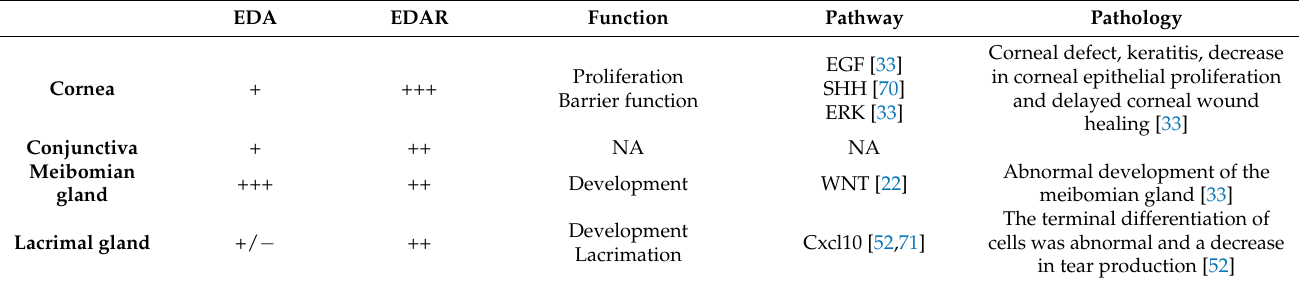
Figure 3. Schematic representation of EDA in ocular surface homeostasis. In ocular surface, the EDA was mainly contributed by meibomian gland. EDA plays a crucial role in maintaining the ocular surface hemostasis by promoting proliferation though EGF signaling pathway and maintaining normal barrier function of corneal epithelium by SHH signaling pathway. Table 2. Expression of EDA and pathways involved in ocular surface